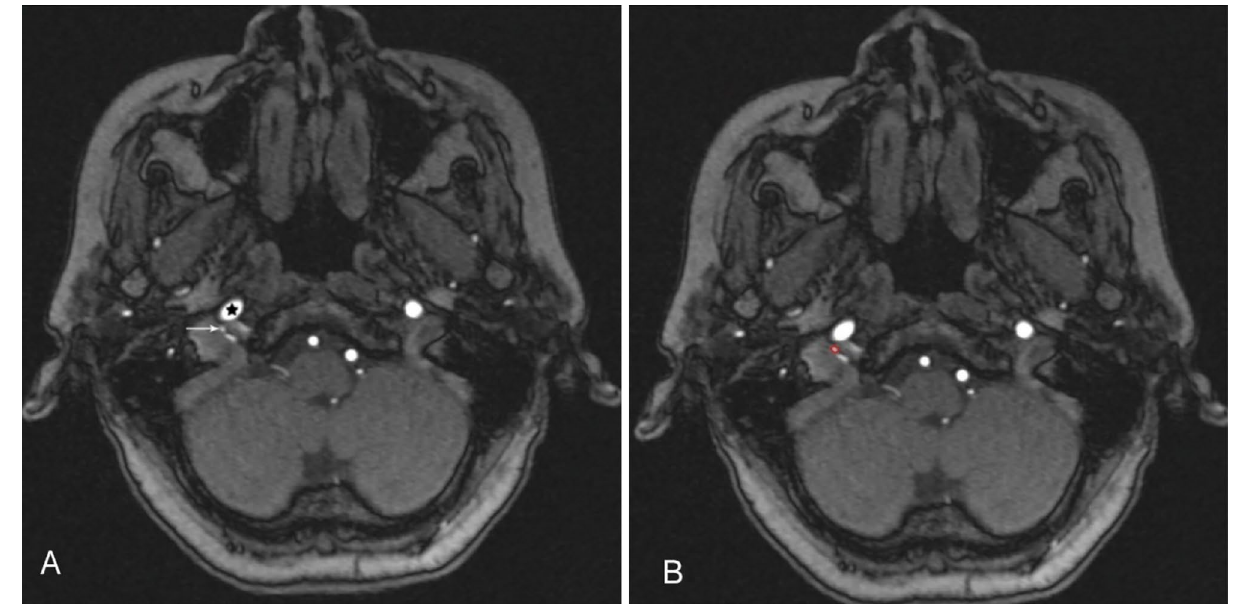
Figure 2. The preoperative axial MRA image of patient with C2 JPs on the right. There is only one intratumor blood vessel and intraoperative blood loss was 100 ml. The black star indicates the internal carotid artery. ( A ) The white arrow indicates intratumor blood vessel. ( B ) The red area represents the maximum cross-sectional area of intratumor blood